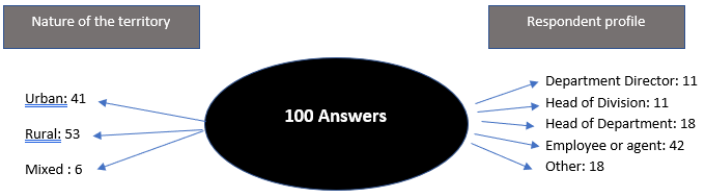
Figure 6. Statistics of variables (source: authors’